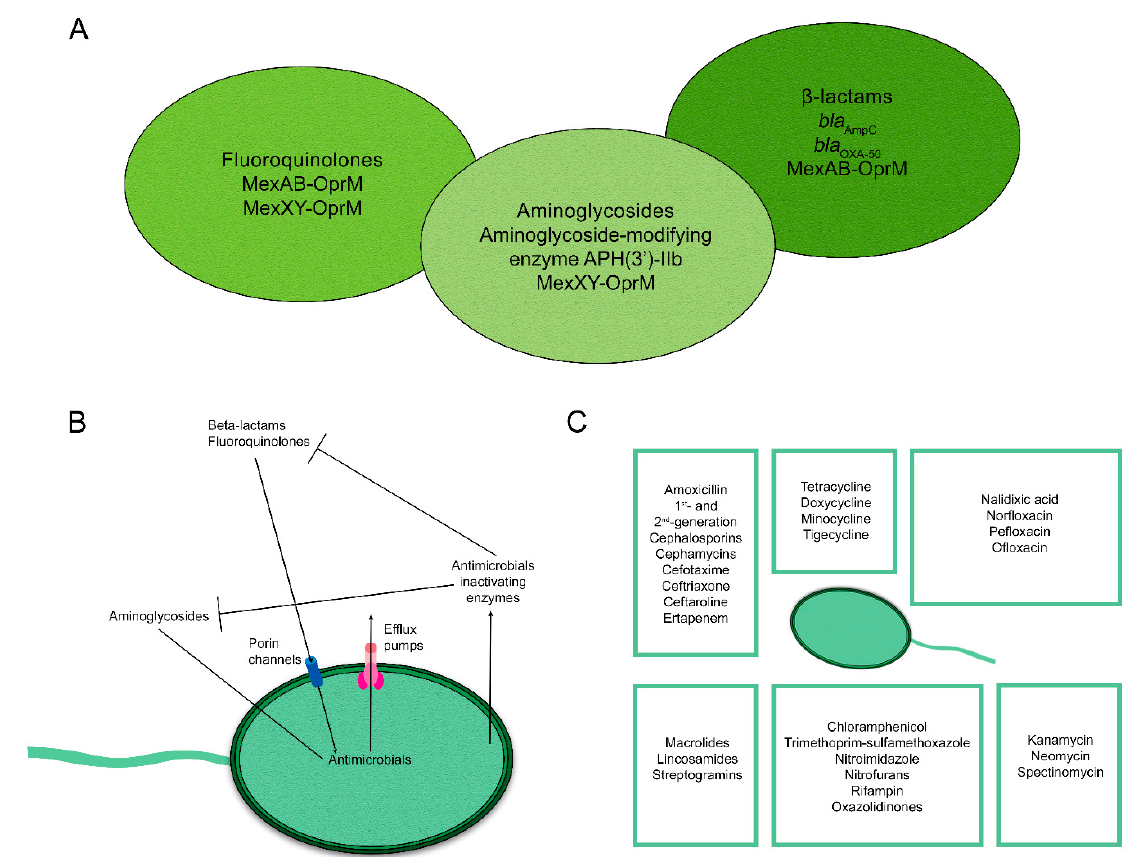
Figure 1. Antimicrobial resistance in Pseudomonas aeruginosa . Mechanisms of intrinsic and acquired AMR in Pseudomonas aeruginosa ( A , B ). The mechanisms include restricted outer-membrane permeability, efflux systems (MexAB-OprM and MexXY-OprM), and the production of antibiotic-inactivating enzymes ( bla AmpC and bla OXA-50 ). A list of the antimicrobials that are ineffective in the treatment of P. aeruginosa infections ( C ).